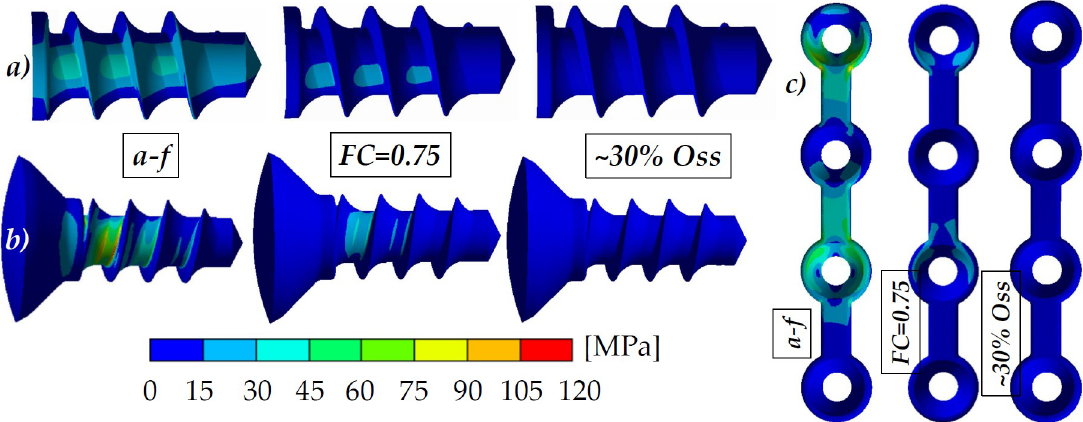
Fig 9. Typical results of von Mises stress distribution in (a) implant (implant holes) and fixation components (b—screws and c–mini- plates) for S 320 variant. As-fixed states were labeled with ,, a-f ”, the values of partly osseointegrated states were labeled with ,, FC = 0 . 75” (Approach I) and ,, ~30% Oss” (Approach